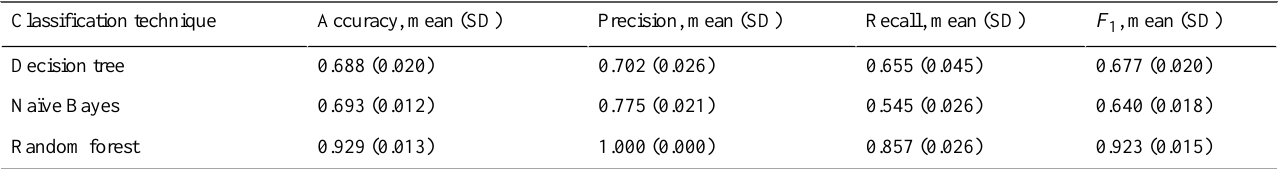
F 1 , mean (SD)Recall, mean (SD)Precision, mean (SD)Accuracy, mean (SD)Classification